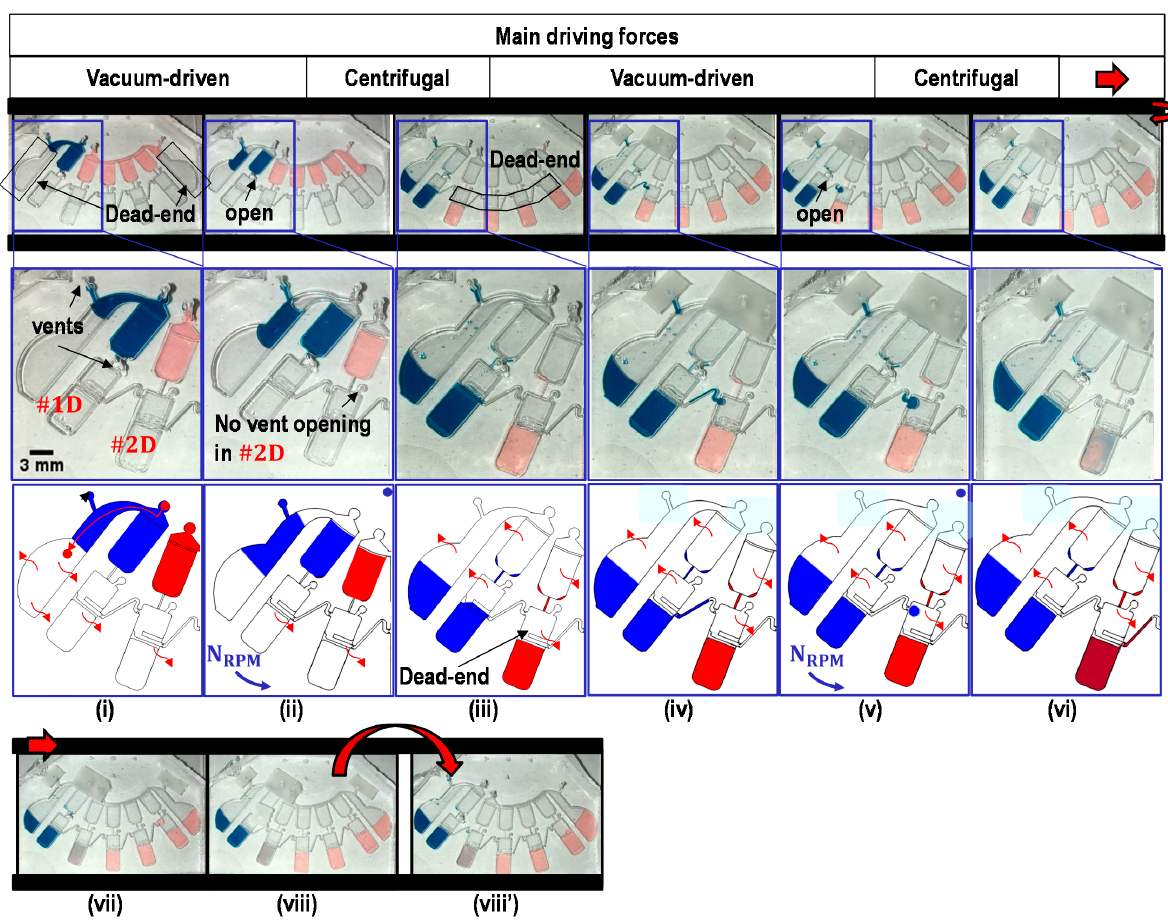
Figure 4. Sequential images of the serial dilution with liquid sample (water containing blue dye) and liquid buffer (water containing red dye): ( i ) liquid loading; ( ii ) liquid metering; ( iii ) liquid transfer from metering chambers into dilution chambers; ( iv ) partial transfer of one-tenth of its original volume from #1D to #2D, where inlets and vents were sealed with adhesive tape, except one vent in #1D; ( v ) and ( vi ) mixing of the liquid sample and the liquid buffer; ( vii ) repeating of the serial dilution process, and ( viii , viii’ ) completed serial dilution showing the device with and without tapes. Here, for clarification, vent ports design located in #2D to #5D were not punched in this study.